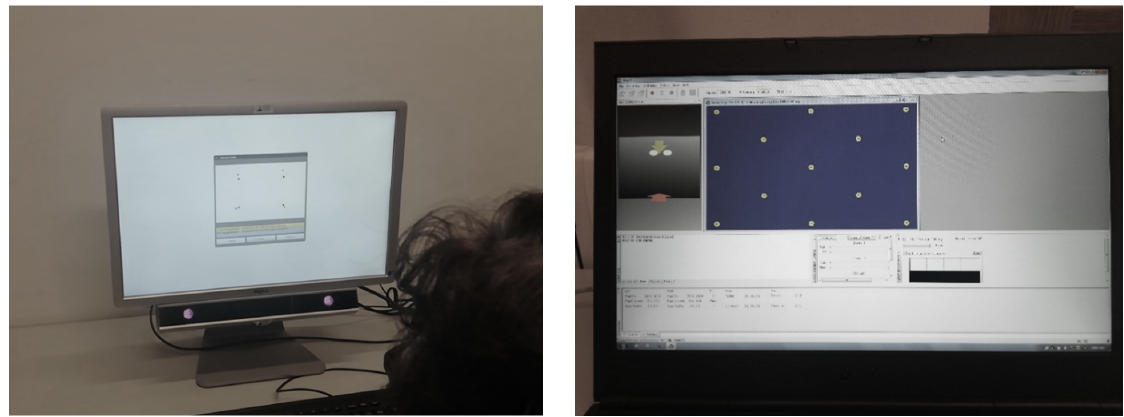
Figure 1. Calibration with eye tracking.